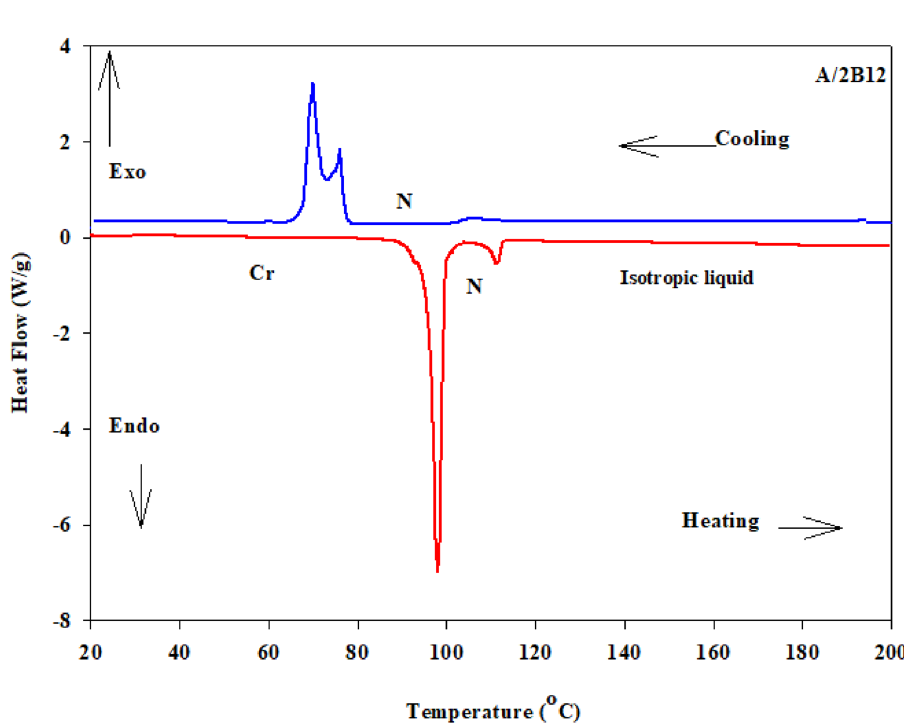
Figure 3. DSC thermograms on heating/cooling rounds with heating rate 10 °C/min of present complex A/2B12 , as representative